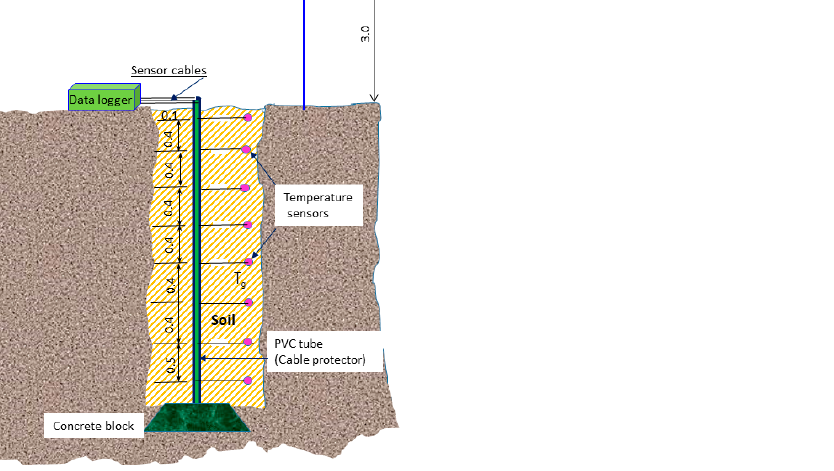
Figure 1. Schematic diagram showing the hole dug into the ground and the locations of thermocou- ples used to measure underground temperatures ( T g ) and ambient temperature ( T am